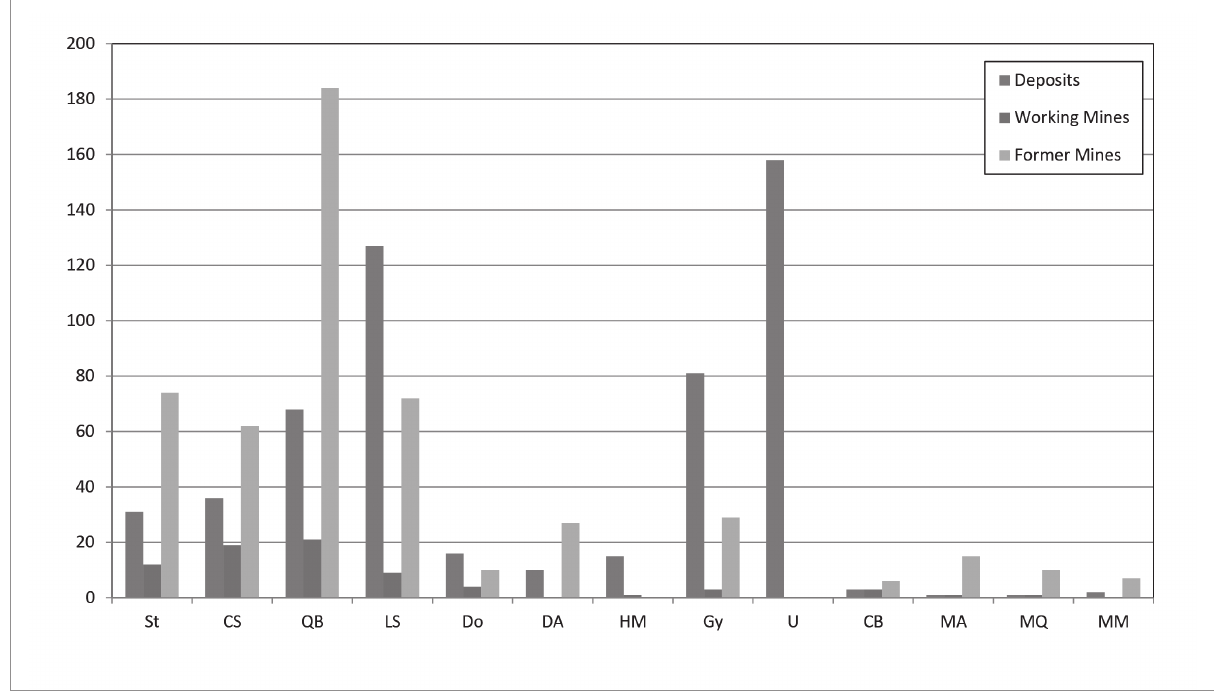
St, stone aggregate; CS, brick clay; QB, building sand; LS, limestone; Do, dolomite; DA, diamonds; HM, heavy minerals; Gy, gypsum; U, uranium; CB, bentonite; MA, granite (dimension stone); MQ, sandstone (dimension stone); MM, marble (dimension stone). Figure 3: The status of potentially economic minerals of the Western Cape